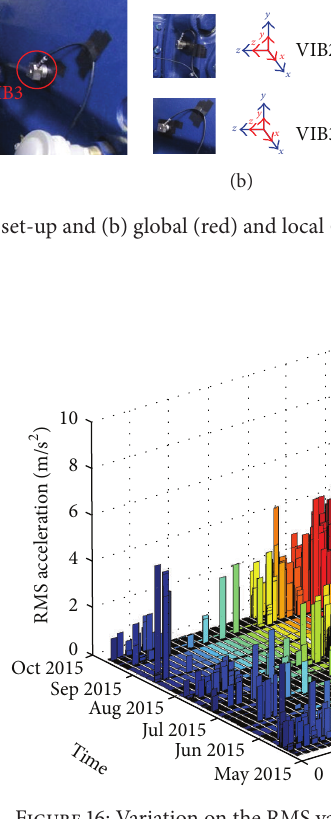
Figure 16: Variation on the RMS value of the acceleration per bin.